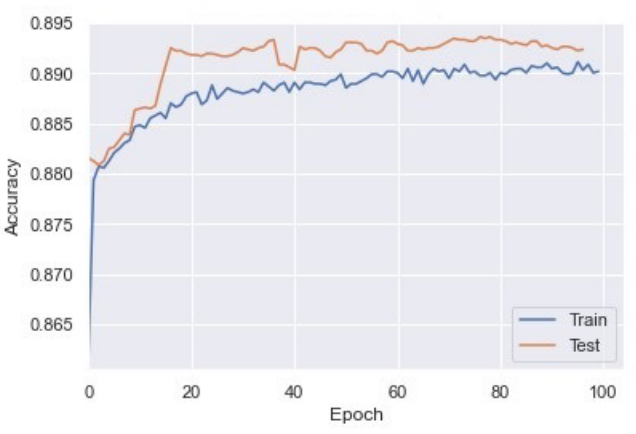
Figure 11. Training and test accuracy of LSTM model for XSS and SQL injection detection.